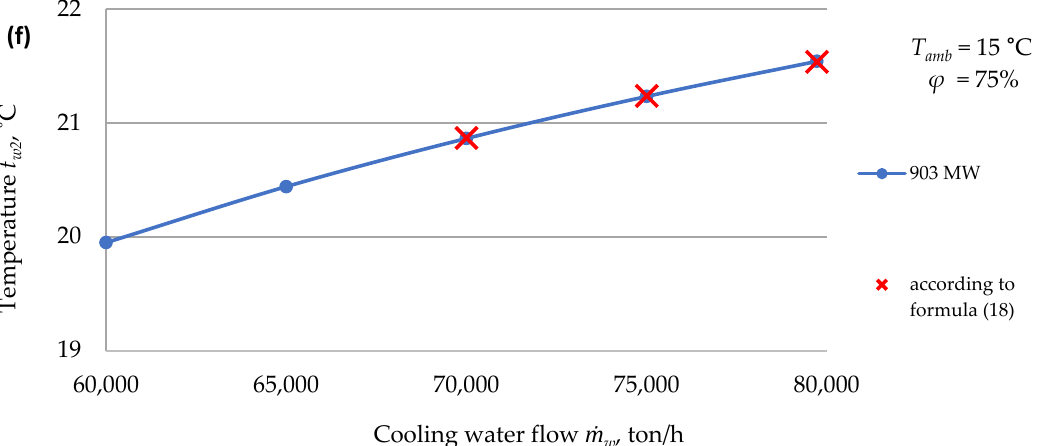
Figure 10. Temperature values at the inflow t w1 and outflow t w2 to/from the cooling tower as a function of cooling water flux for ambient temperature: ( a , b ) 5 °C; ( c , d ) 25 °C; ( e , f ) after considering the results obtained using Formula (18).